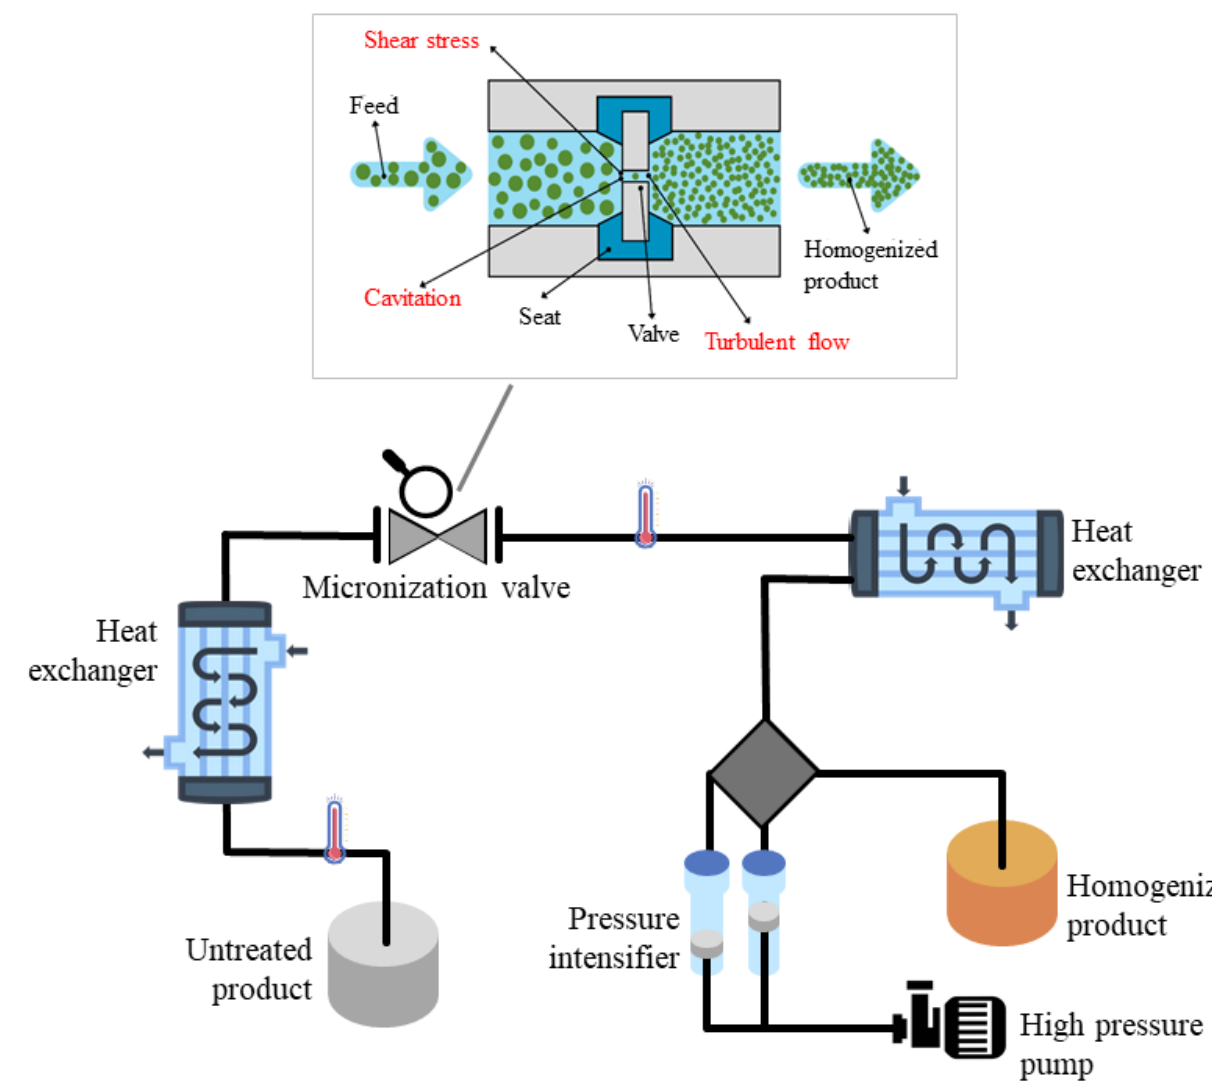
Figure 8. Schematics of the operating principle of a typical HPH system and focus on the homogenization valve.